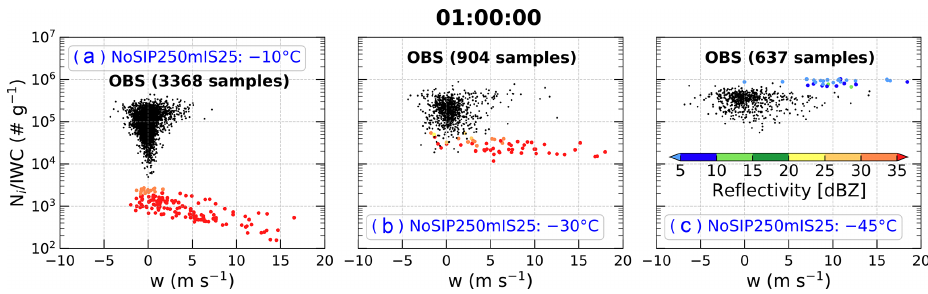
Figure 5. As in Fig. 4 but for the experiment NoSIP250mIS25 overlaid with observations in Fig. 3.